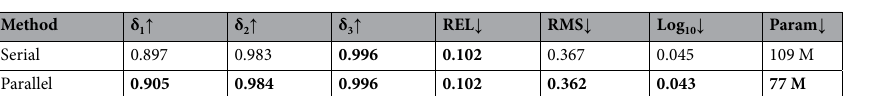
Table 6. Quantitative comparison of serial and parallel decoders. The better results are shown in